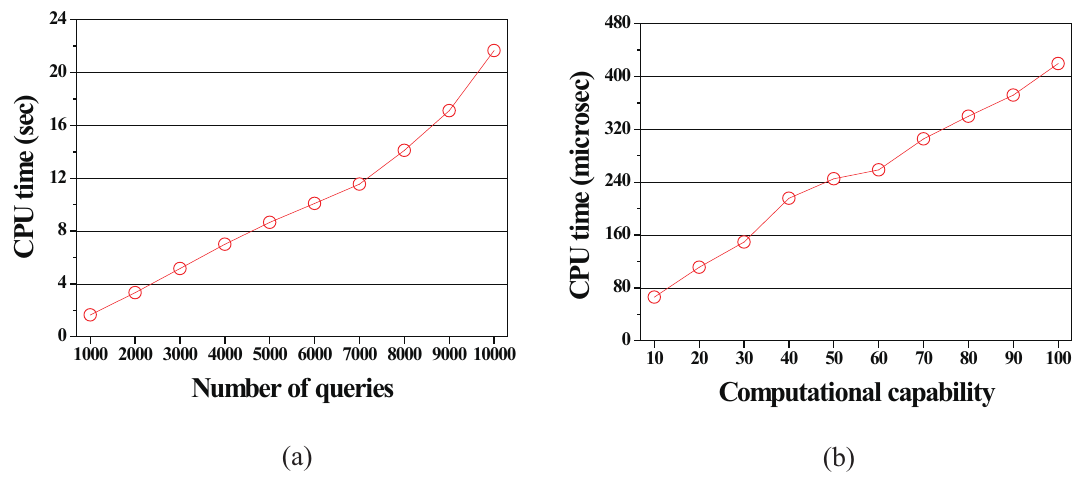
Figure 11. Construction time of the SSP-tree and CPU-time consumed by a moving object. ( a ) Construction time of the SSP-tree vs. the number of queries; ( b ) The amount of CPU-time consumed by a moving object in DM (SSP-tree) vs. the minimum computational capability; all other parameters have their default values (see the values stated in boldface in Table